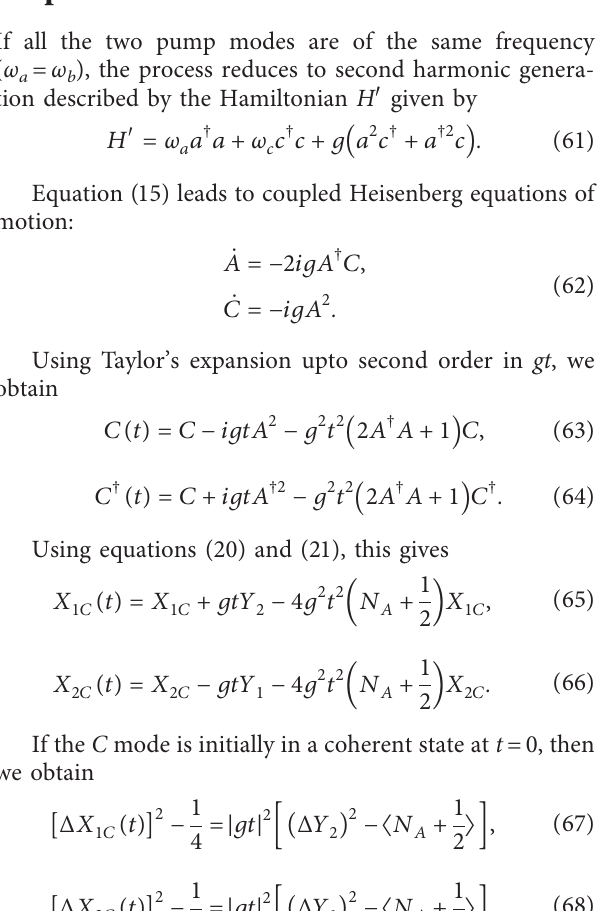
Figure 4: Variation of the sum squeezing S degenerate frequency upconversion